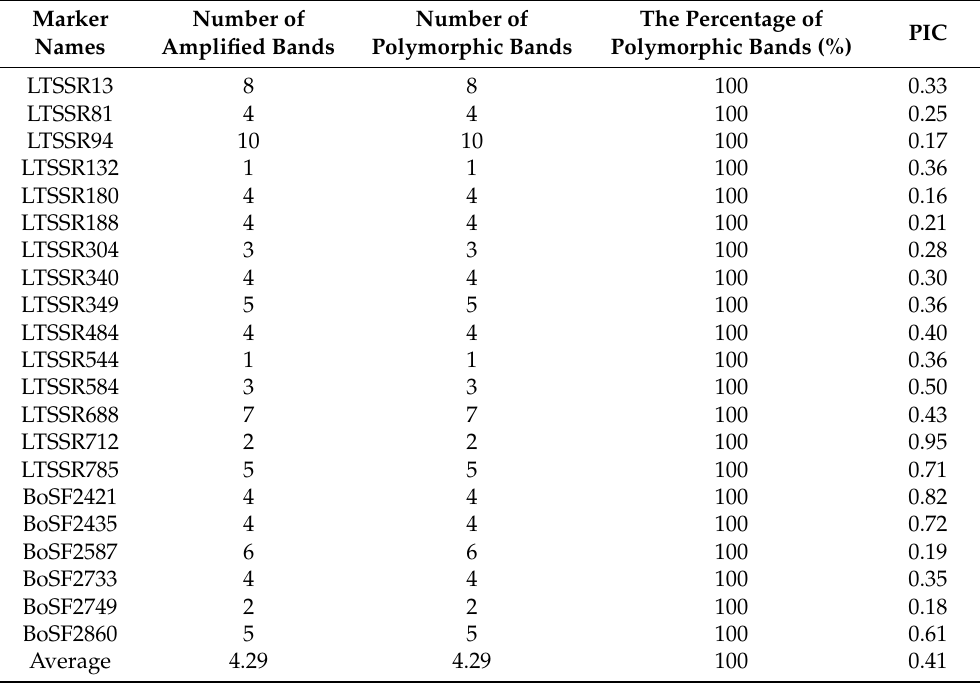
Table 3. SSR markers used in this study and their amplification